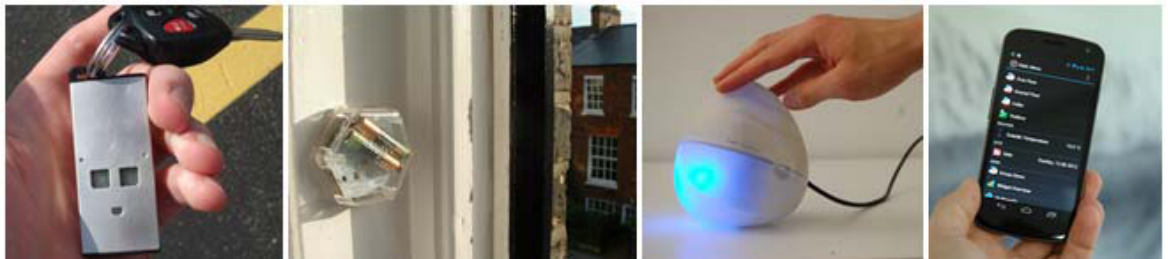
Figure 9. IOT Home Automation and Environment Monitoring Innovations: Sensordrone, Flexibity Internet Sensors, Air Quality Egg, and openHAB on